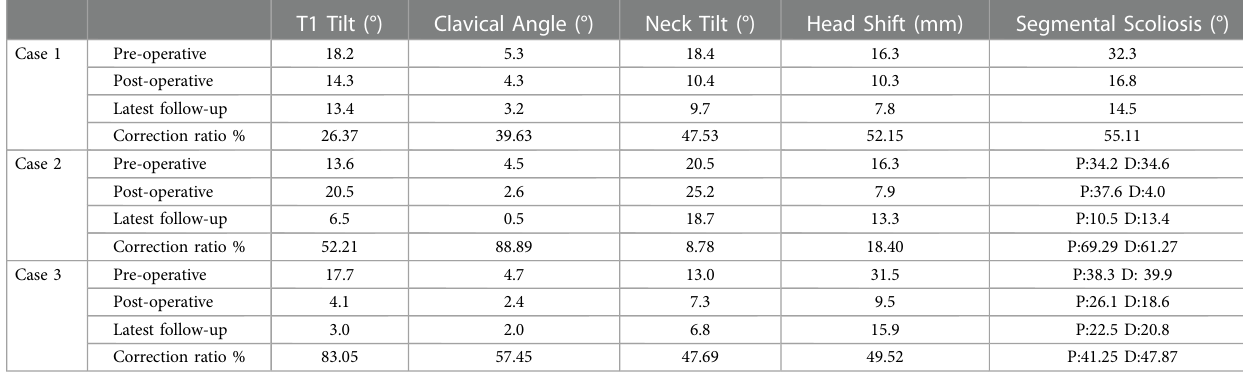
TABLE 2 Demographic: changes in the coronal and sagittal